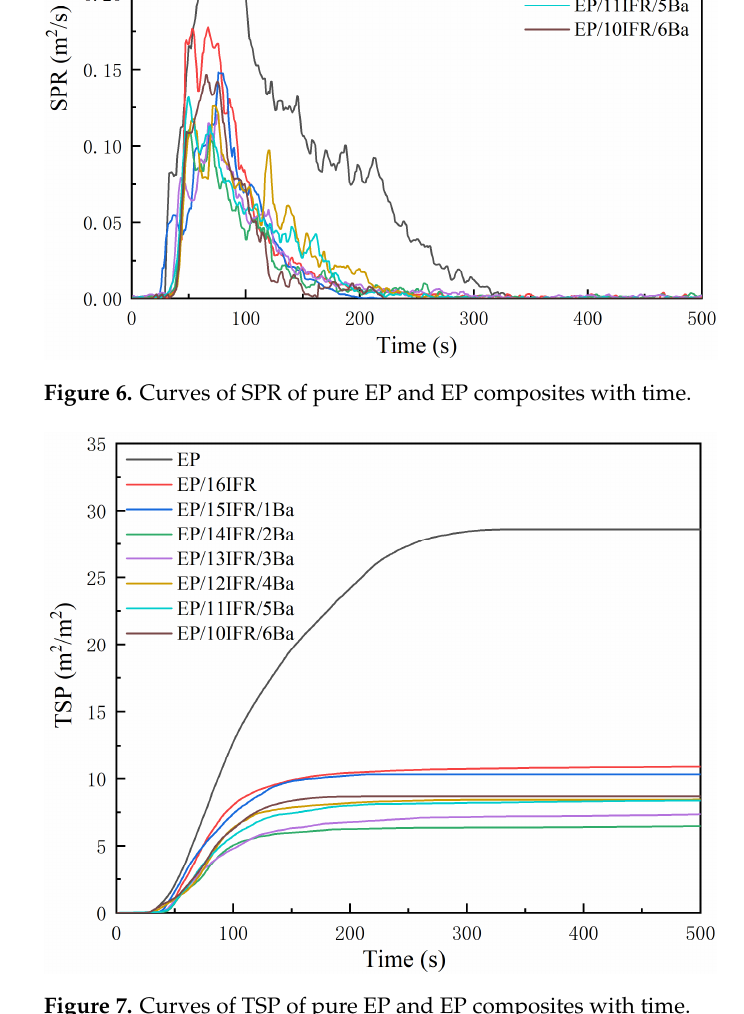
Figure 7. Curves of TSP of pure EP and EP composites with time.